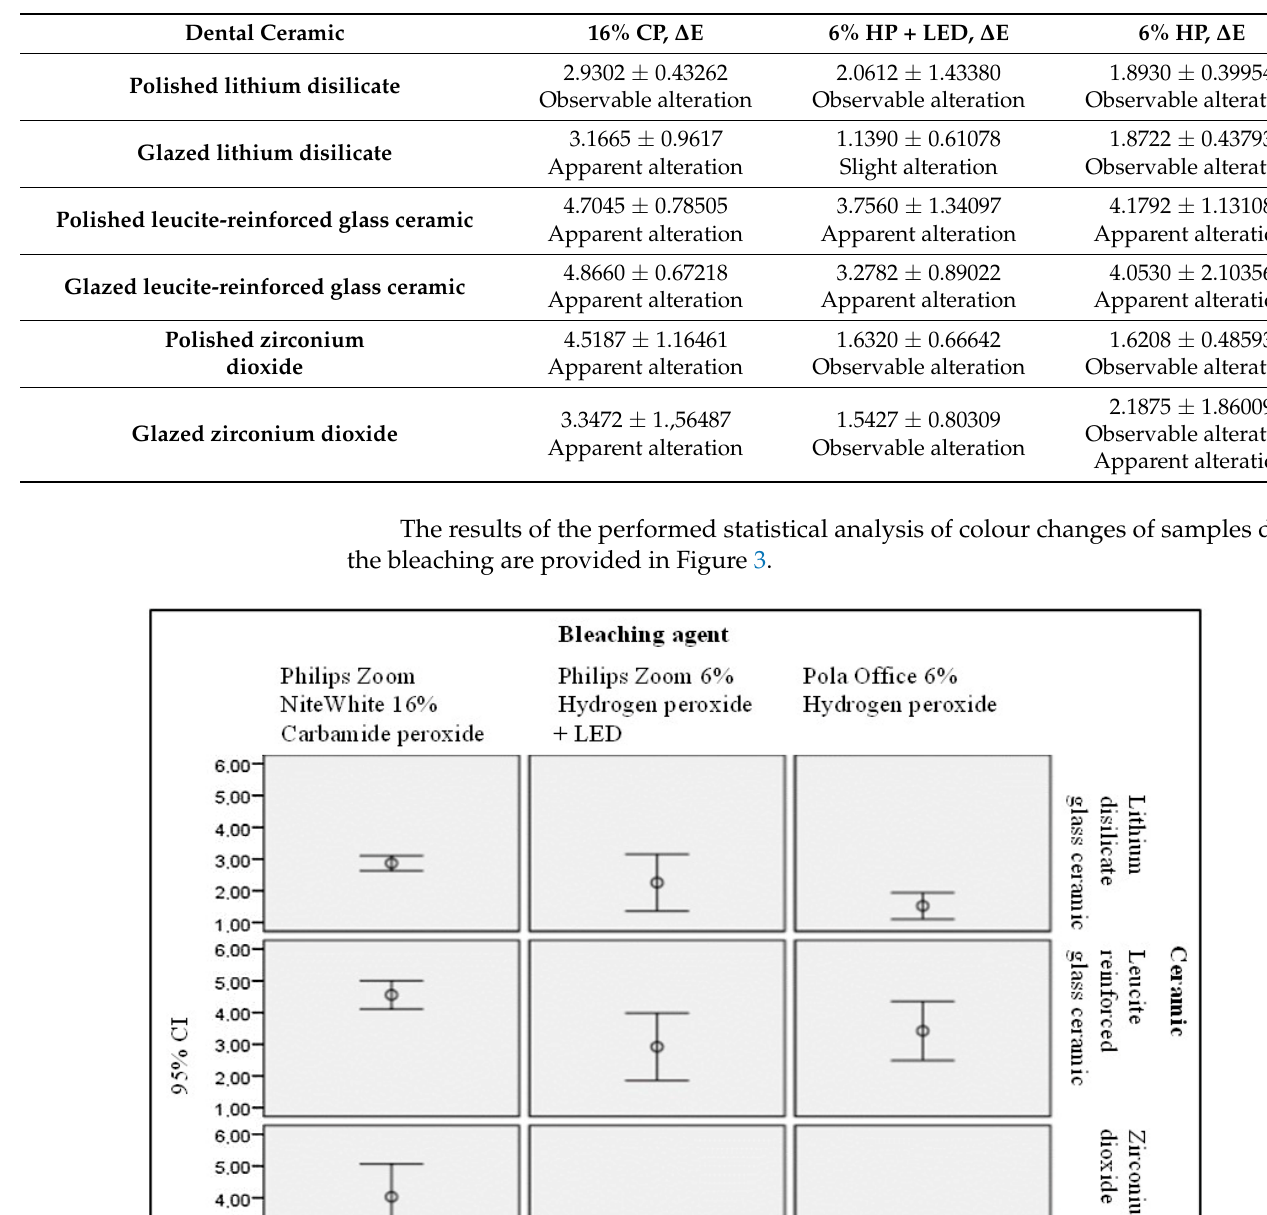
Table 4. Mean values ± standard deviations of ceramics colour alteration after bleaching ( ∆ E).